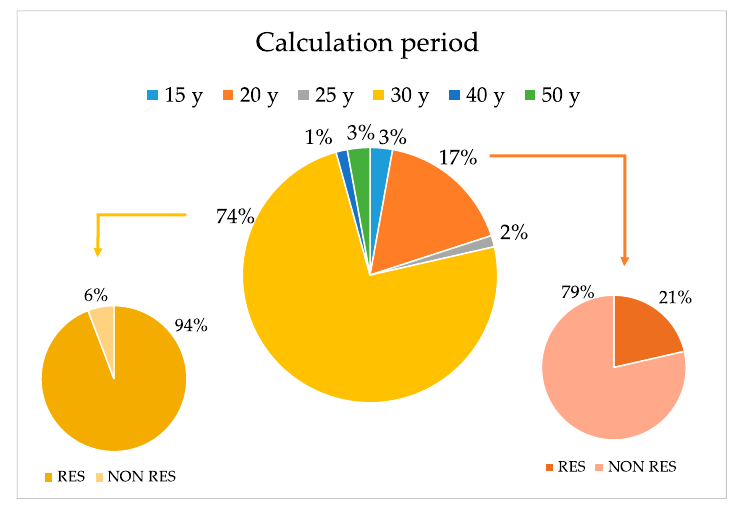
Figure 18. Analysis of the calculation periods used in the analyzed set of studies.